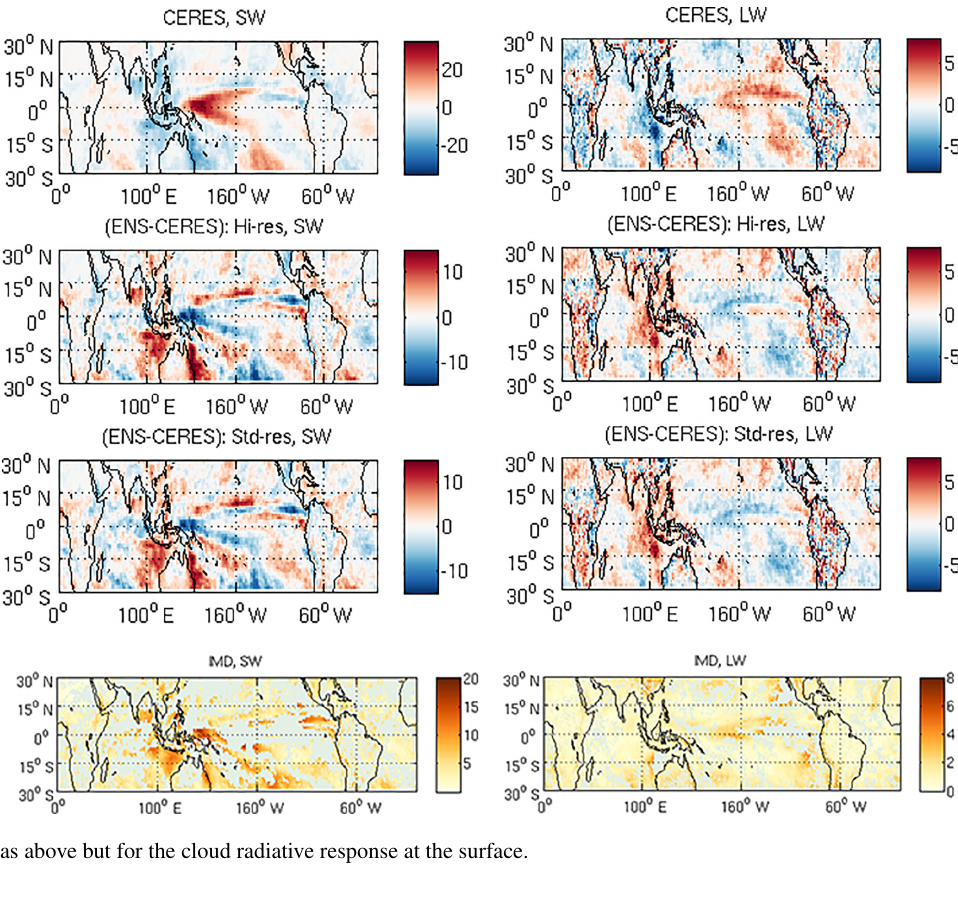
Figure 8. Same as above but for the cloud radiative response at the surface.